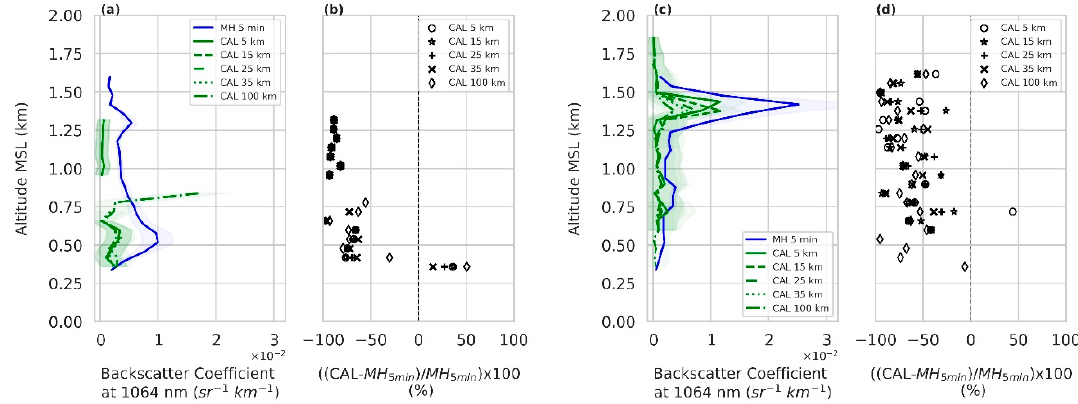
Figure 4. Backscatter Coefficient at 1064 nm profiles and the corresponding mean percentage difference as a function of altitude m.s.l. for a CALIOP overpass at Mace Head on ( a , b ) 18 November 2014 (cloud–free case) at 13:41:22 UTC at 29.56 km distance from Mace Head and ( c , d ) 19 July 2016 (case with a thin cloud) at 03:11:35 UTC at 60.11 km distance from Mace Head. The comparison uses CALIOP 5 km, 15 km, 25 km, 35 km and 100 km along–track averages (1, 3, 5, 7, and 20) vertical profiles) and Mace Head 5 min temporal resolution (1 vertical profile). The shaded areas represent the standard deviation of the measurements for CALIOP and the backscatter retrieval uncertainties for Mace Head.